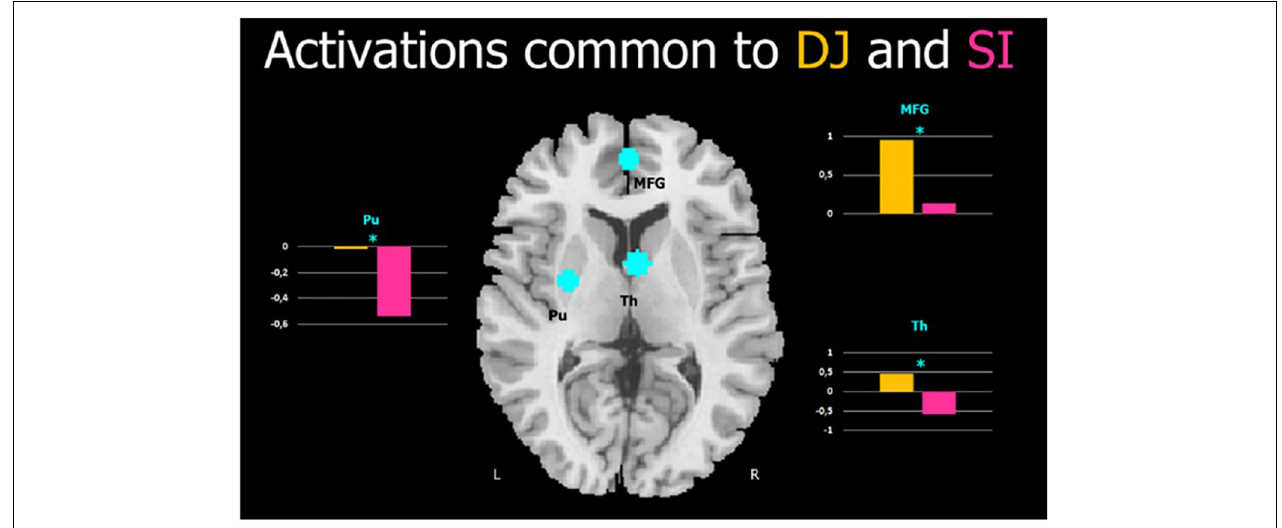
FIGURE 4 | Cortical activation common to DJ and SI. Cyan blobs represent the three functional ROIs from the SI > N contrast (anatomical template found in xjview toolbox). Plots represent mean beta values for each ROIs and each condition (DJ and N); MFG, Medial Frontal Gyrus; Th, Thalamus; Pu, Putamen; L, left; R, right. *indicate significant